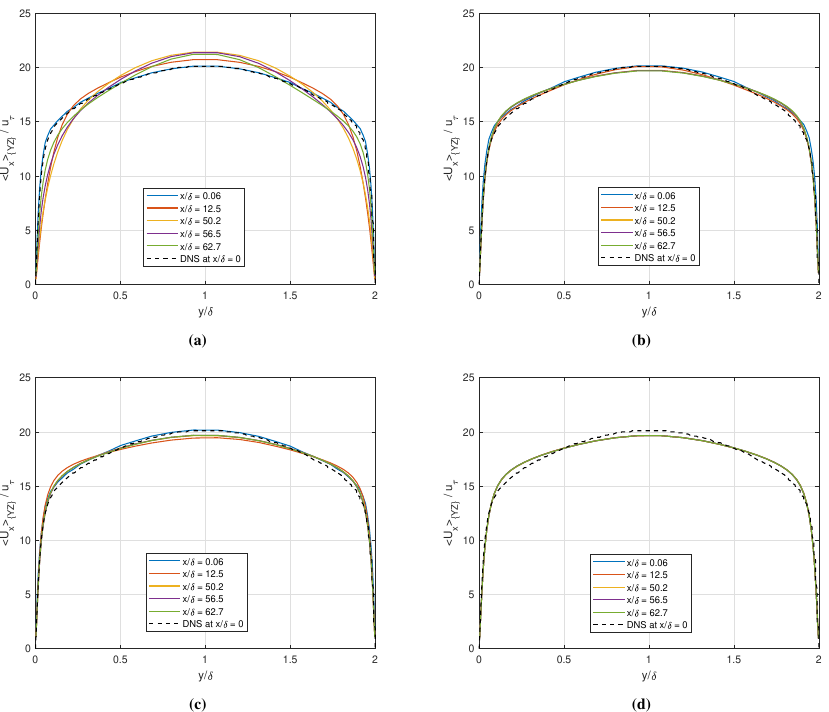
Figure 2: Mean velocity profiles at selected streamwise locations using various inlet conditions as ( a ) 1 cell Per Eddy ( b ) 3 cells Per Eddy ( c ) 5 cells Per Eddy ( d ) a consistent trend in the results. These behaviors in the results show that further mesh refinement is still required to get a converged value for the integral length scales, especially in the streamwise direction, since the difference in the results for Mesh 3 and 2 is still big. Table 2: Integral length scales